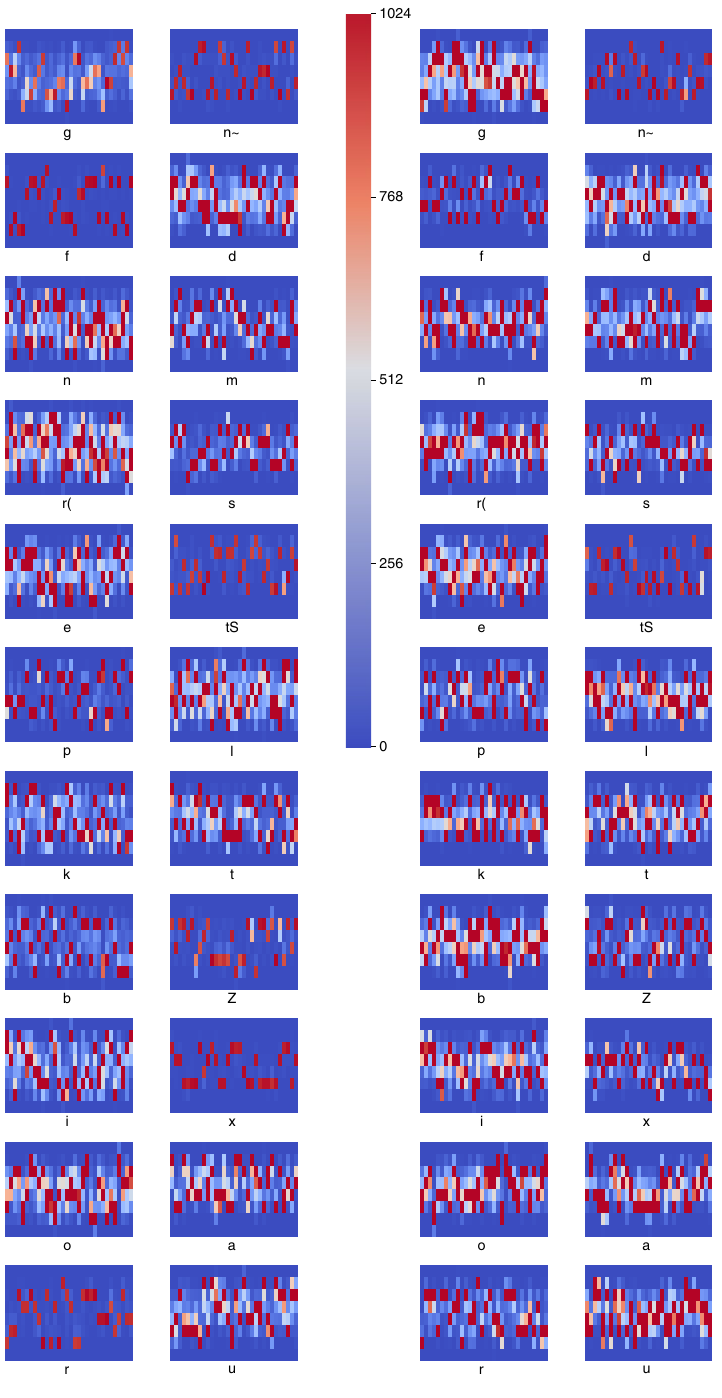
Figure 9. Phonetic memories at the initial (left) and final states (right) of the learning process for the scenario